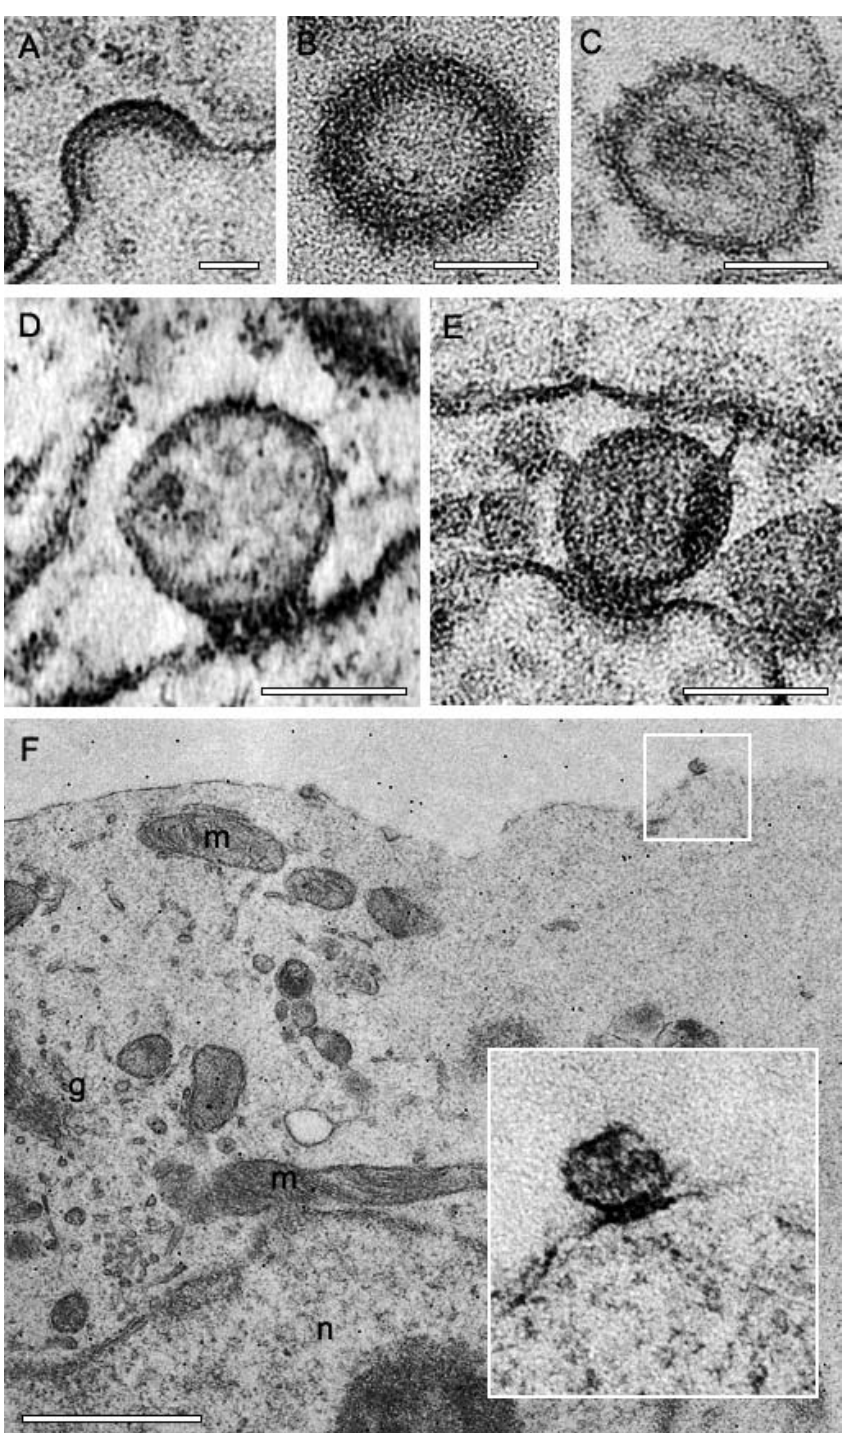
Figure 4. Projection Images from SIV-Infected Cells and from T Cells Exposed to SIV for Short Periods (A–C) Electron microscopic images of budding (A), immature (B), and mature (C) SIV particles in chronically infected cell suspensions. Scale bars are 50 nm long. (D and E) Distinct virus–cell contacts in chronically infected cells that are defined by a characteristic density at the interface between the virus and the cell membrane, and distinct from virus morphologies seen in (A–C). Note that in some instances (E), the curvature of the cell membrane follows the curvature of the virus where the contact is made. Scale bars are 100 nm long. (F) Projection image (higher magnifications shown in inset) of the contact region between SIV virions and T lymphocytes fixed after incubation at 37 8 C for 15 min. At lower magnifications the overall context of the cell in the vicinity of the contact region is shown, while at the higher magnifications, entry claw contacts can be recognized in the projection view. Scale bar is 1 l m long. G, part of the Golgi ribbon; m, mitochondria; n, nucleus.